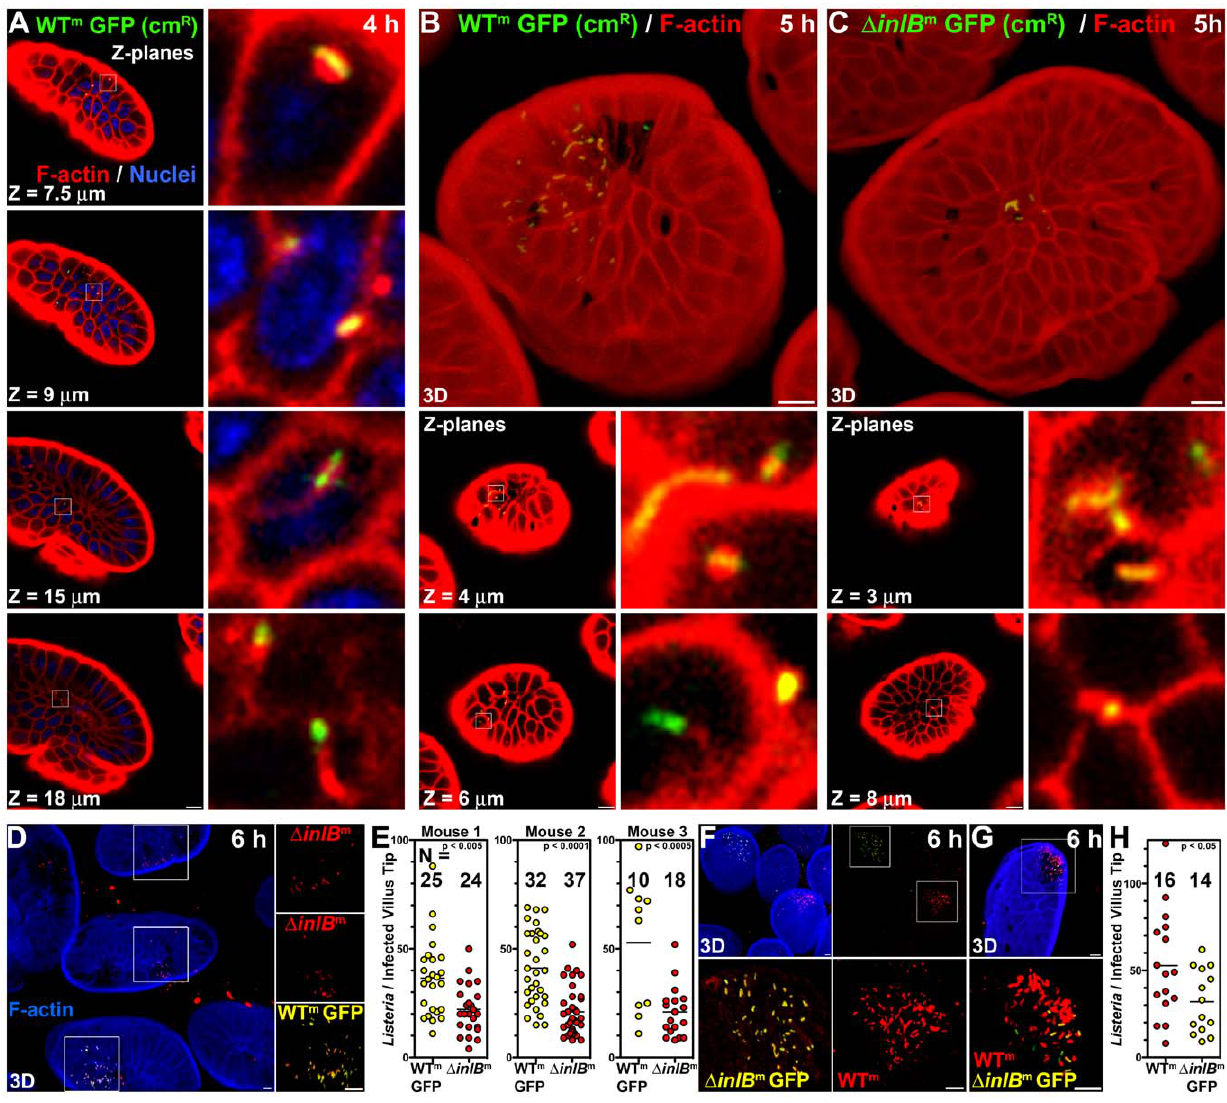
Figure 1. InlB-mediates invasion of intestinal villus tips. (A) Confocal Z-planes of an ileal villus tip from a mouse infected with 10 10 CFU WT m GFP for 4 h and counterstained for F-actin, red, and nuclei, blue. Insets show intracellular Lm with associated F-actin. Depth from the apical cell surface, Z, is indicated. (B) Top panel, a 3D confocal reconstruction of an ileal villus tip of a mouse infected with 10 10 CFU WT m GFP for 5 h and counterstained for F-actin, red. Lower panels, Z-planes and insets of intracellular Lm with associated F-actin. (C) Top panel, a 3D confocal reconstruction of an ileal villus tip of a mouse infected with 10 10 CFU D inlB m GFP for 5 h and counterstained for F-actin, red. Lower panels, Z-planes and insets of intracellular Lm associated with F-actin. (D–E) Coinfection with 5 6 10 9 CFU each WT m GFP and D inlB m Lm for 6 h. Tissue was stained with phalloidin for F-actin, blue, and for all Lm , red. (D) 3D confocal reconstruction of infected villus tips. (E) Quantification of Listeria per infected villus tip for 3 mice. (F–H) Coinfection with 5 6 10 9 CFU each WT m and D inlB m GFP Lm for 6 h. Tissue was stained with phalloidin for F-actin, blue, and for all Listeria , red. (F) Top left, 3D confocal reconstruction of infected villus tips. Top right, F-actin staining from the top left panel is omitted to show all Lm . Bottom panels, zoomed insets from top right. (G) A rare villus tip infected with both WT m and D inlB m GFP Lm . (H) Quantification of Listeria per infected villus tip. Scale bars, 10 m m.